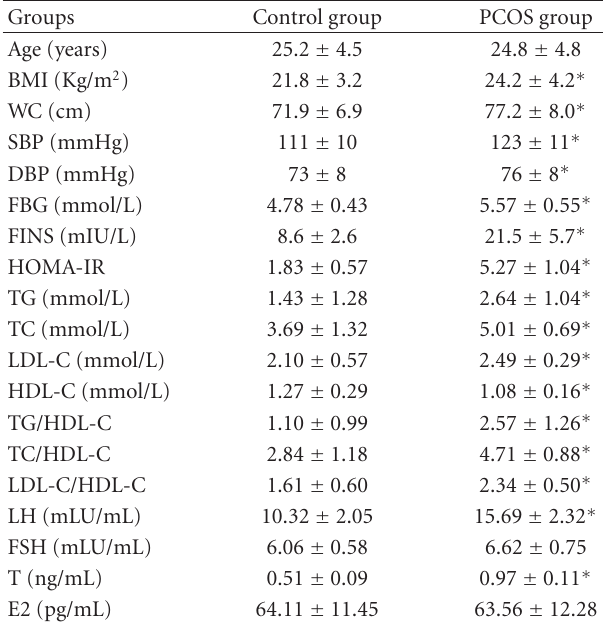
Table 1: Demographic data in PCOS and control groups ( ∗ P < 0 . 05).